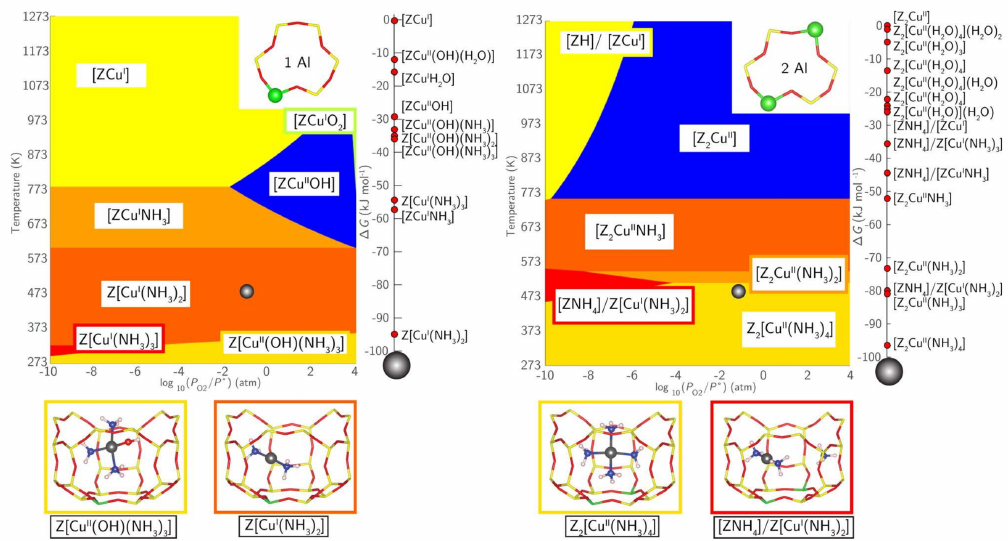
Figure 7. Phase diagrams for 1Al ( left ) and 2Al ( right ) sites with varying T and PO 2 at 300 ppm of NH 3 and 2% H 2 O. Relative rankings for all stable species— ∆ G form < 0 at 473 K and 10% O 2 (chrome spheres on the phase diagrams)—are given to the right of each phase diagram. The structures shown on the bottom are the most stable CuI (red outline) and CuII (golden outline) species under these